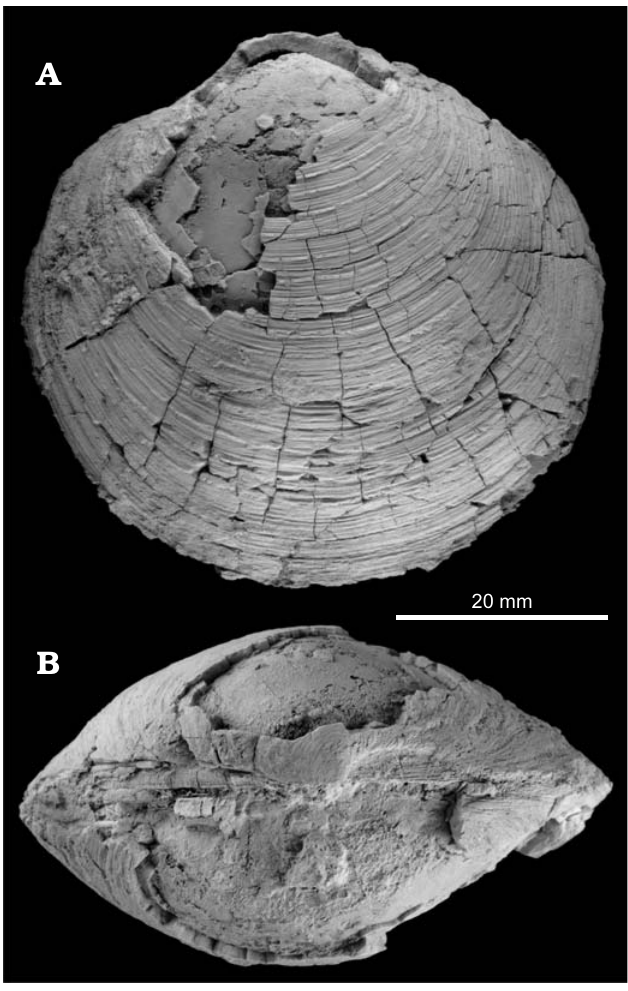
Fig. 8. The large lucinid bivalve Lucinoma sp. from the late Pliocene of Italy, Stirone River seep deposit. MGGC.22016, view of left valve ( A ), dorsal view ( B